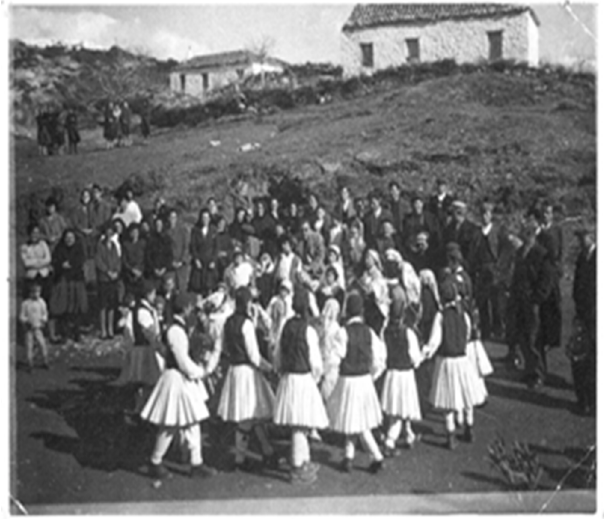
Figure 10. Antonis attending a school celebration (author’s collection).